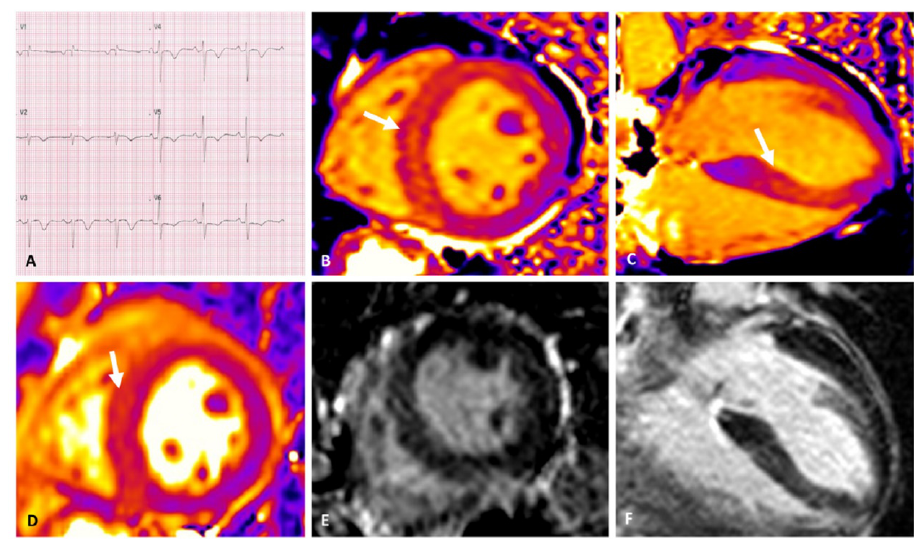
Figure 2. ECG with diffuse T- wave inversion ( A ). Native T1 mapping, higher signal detected within the interventricular septum in the mid-short axis (arrow in ( B )) and in 4-chamber view (arrow in ( C )); in the same area; T2 mapping shows higher signal intensity indicating edema (arrow in ( D )). Absence of replacement fibrosis as assessed by LGE ( E , F ). Adapted with permission from [18].